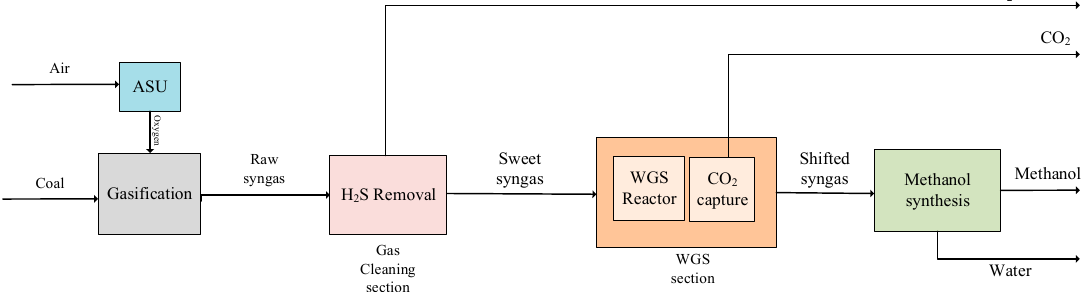
Figure 3. Block flow diagram for the modified design-1 (MD1-CTM) process.